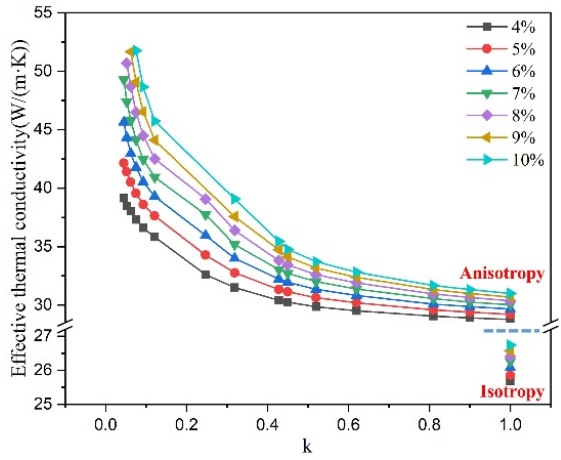
Figure 4. Effect of graphite shape parameter on effective thermal conductivity of cast iron, λ m = 25 W/(m · K) and spherical type: k = 1; capsule-based type: 0.9 > k > 0.24; disc type: 0.12 > k > 0.04.